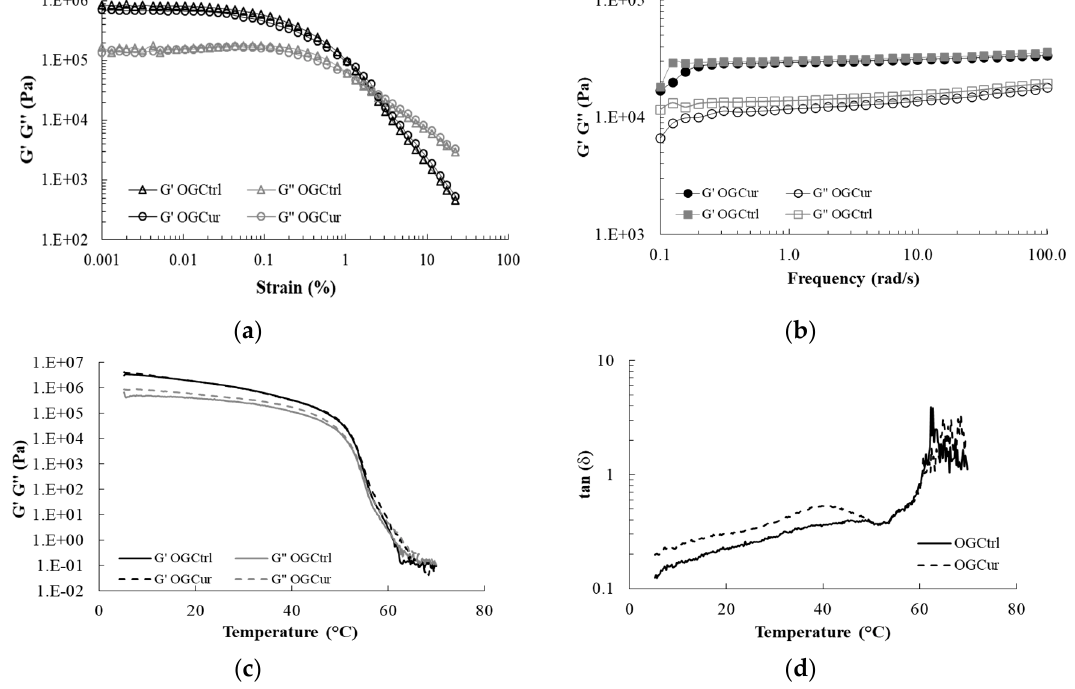
Figure 4. ( a ) G’ and G’’ as a function of strain during amplitude sweeps for OGCur and OGCtrl. ( b ) G’ and G’’ as a function of frequency for OGCur and OGCtrl. ( c ) G’ and G’’ as a function of temperature during heating from 5 °C to 70 °C for OGCur and OGCtrl. ( d ) Tan ( δ ) values a function of temperature during heating from 5 °C to 70 °C for OGCur and OGCtrl.